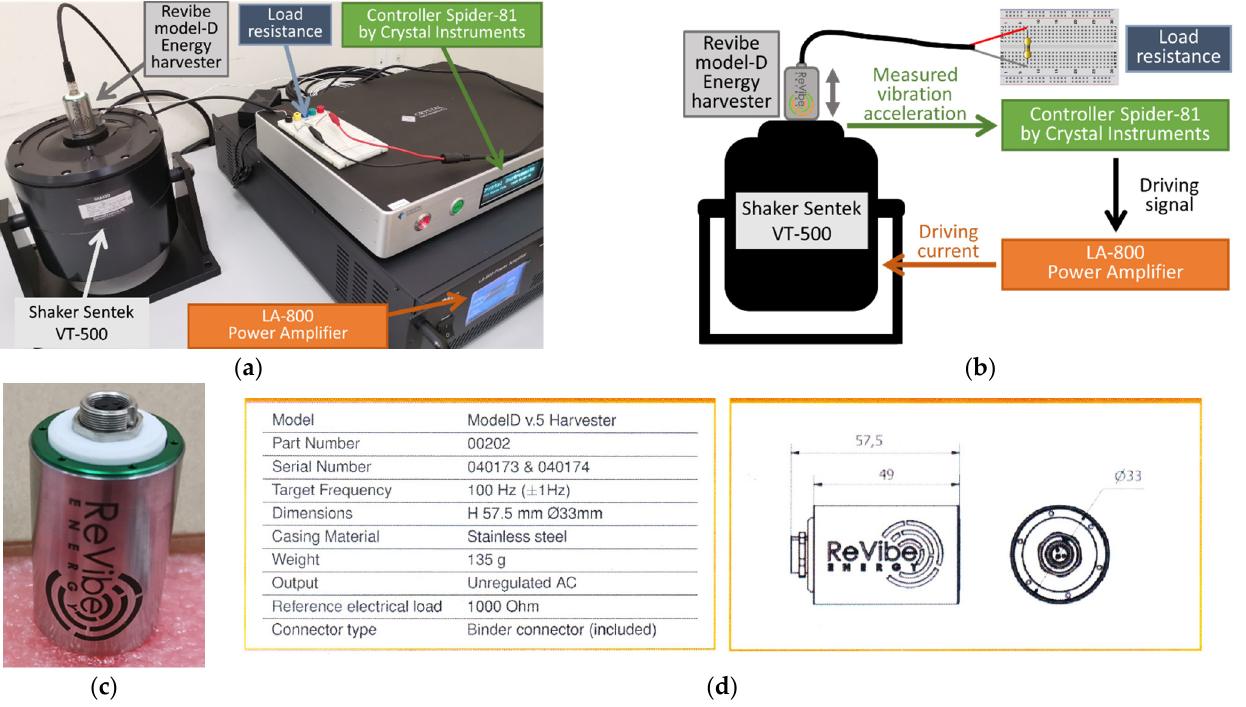
Figure 6. ( a ) Characterization setup for the electromagnetic energy harvester model-D by ReVibe. ( b ) Block diagram of the characterization setup. ( c ) Photo of the harvester. ( d ) Technical parameters of the harvester as reported in the datasheet.